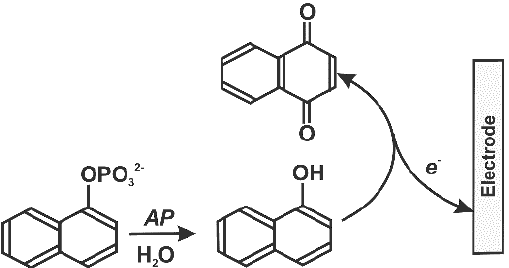
Figure 11. Voltammetric determination of alkaline phosphatase (AP) activity with α -naphtyl phosphate as substrate.